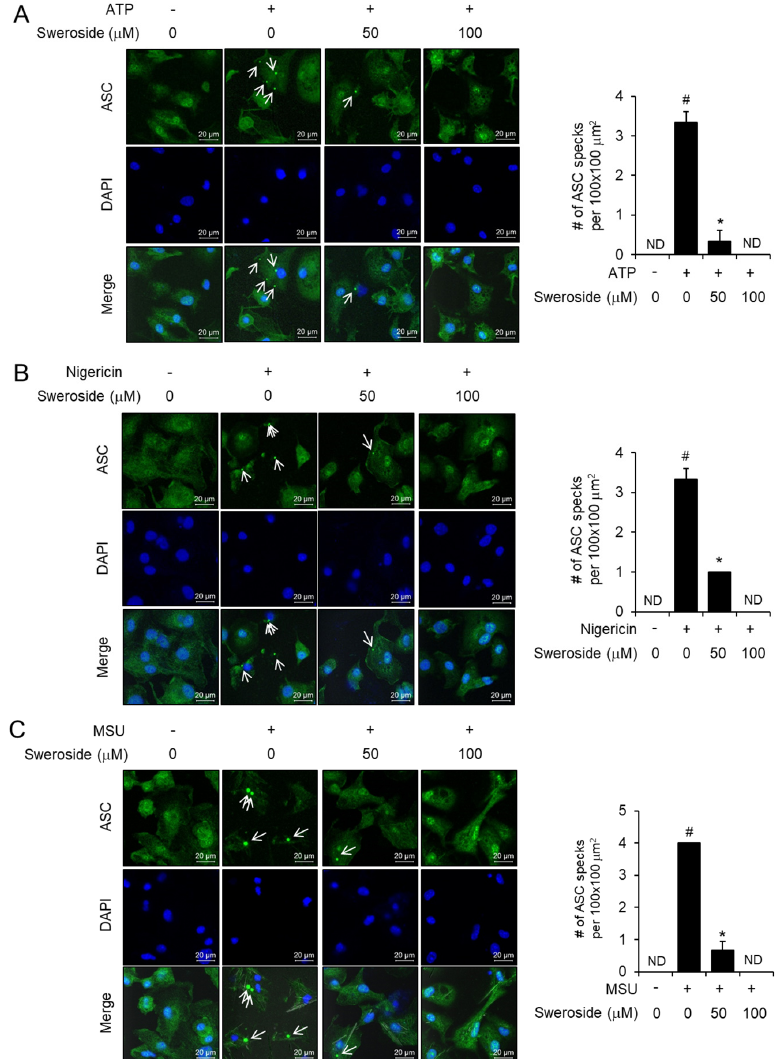
Figure 2. Sweroside blocks the formation of ASC specks in primary macrophages. ( A – C ) Bone marrow-derived macrophages (BMDMs) were fixed, permeabilized, and stained for ASC (green). The nuclei were stained with 4 ′ ,6-diamidino-2-phenylindole (DAPI: blue). The arrows indicate ASC specks. The number of ASC specks per 100 × 100 µm 2 was obtained from different fields of view and is presented as a bar graph. The values represent the means ± SEM ( n = 3). #, significantly different from vehicle alone, p < 0.05. *, significantly different from ATP, nigericin, or MSU alone, p < 0.05. ND, not detected. Scale bars = 20 µm.